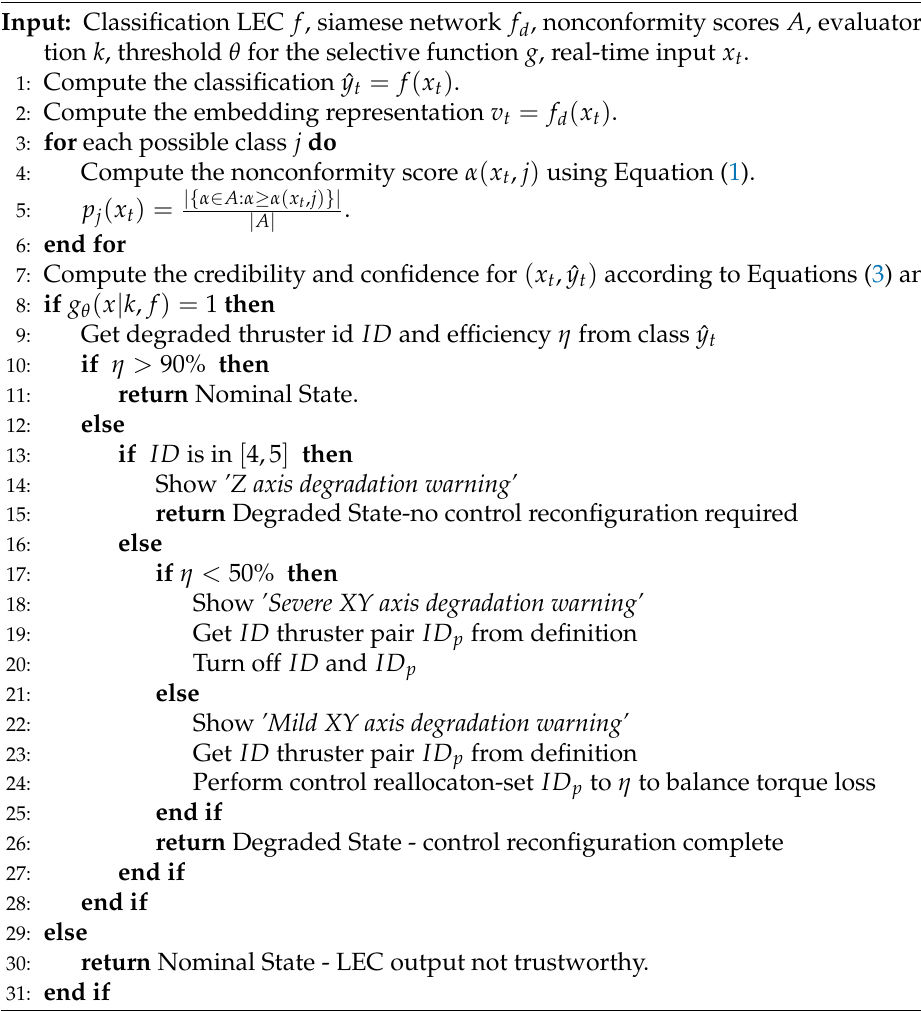
Algorithm 3 Execution-time Steps for BlueROV